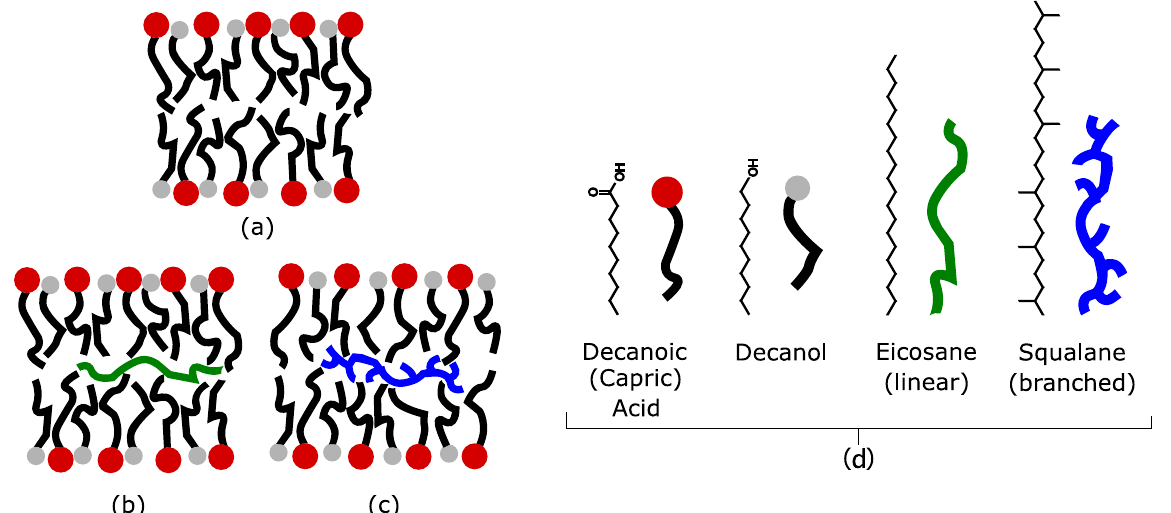
Fig. 1 Protomembrane models. Sketch of the three protomembrane models investigated in this study. a C10 mix; b C10 mix + 2% eicosane; and c C10 mix + 2% squalane. d Molecular structure and name of each compound